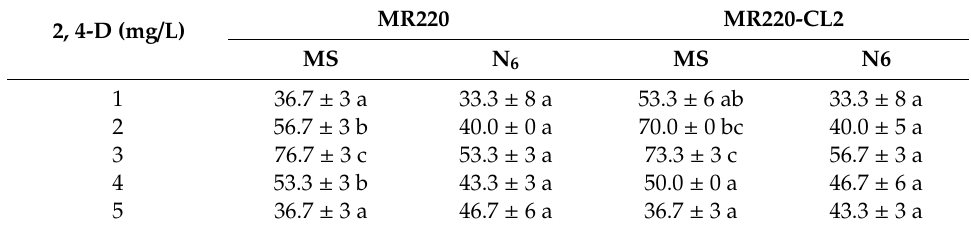
Table 1. E ff ect of the media type and various 2, 4-D concentrations on the callus percentage of MR220 and MR220-CL2 cultivars.